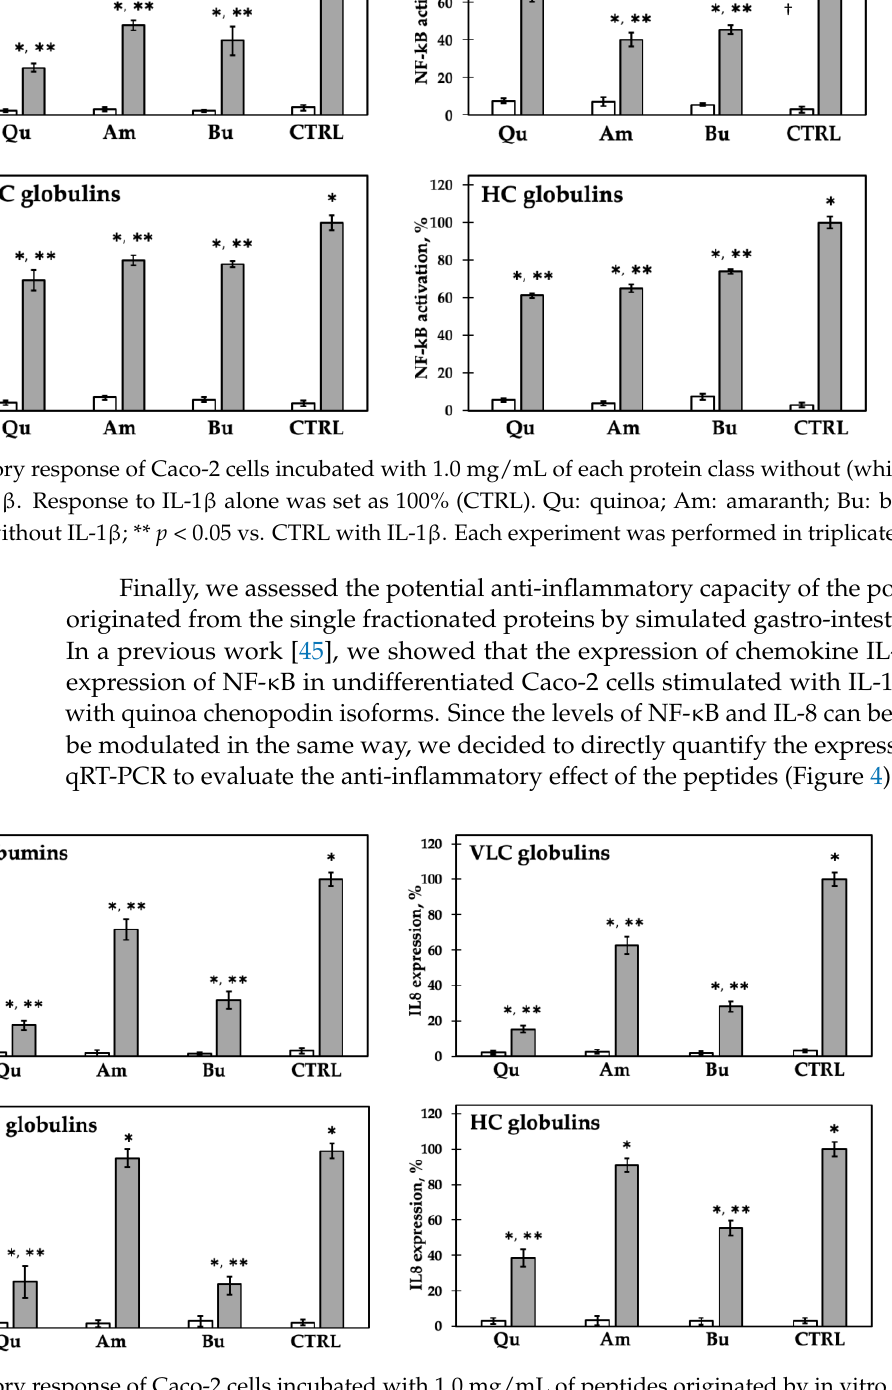
Figure 4. Inflammatory response of Caco-2 cells incubated with 1.0 mg/mL of peptides originated by in vitro simulated gastro-intestinal digestion of each protein class, without (white bars) or with (gray bars) IL- 1β. Response to IL - 1β alone was set as 100% (CTRL). Qu: quinoa; Am: amaranth; Bu: buckwheat. * p < 0.05 vs. CTRL without IL- 1β; ** p < 0.05 vs. CTRL with IL- 1β. Each experiment was performed in triplicate.